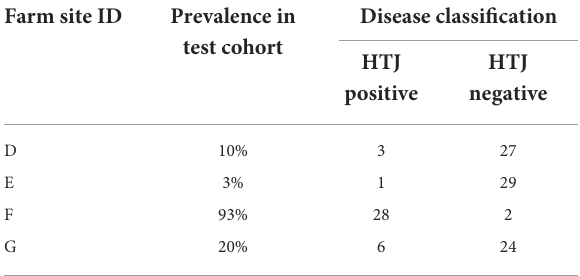
TABLE 1 Prevalence of Johne’s disease